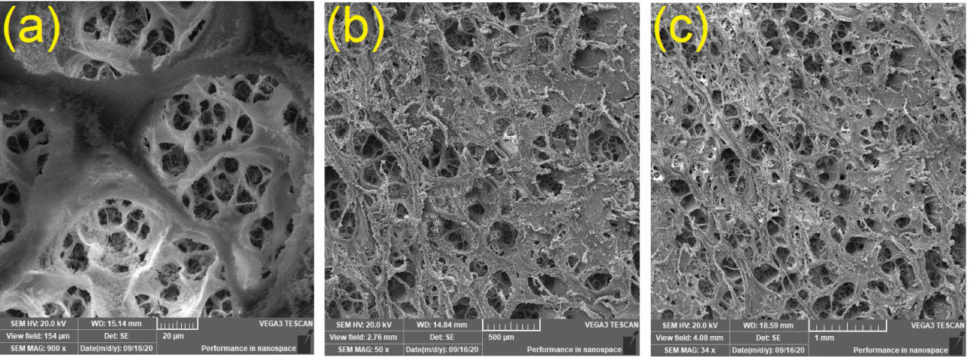
Figure 1. SEM images of CA membranes after washing out CaCO 3 for CA ( a ) and CA-GO-2 ( b , c